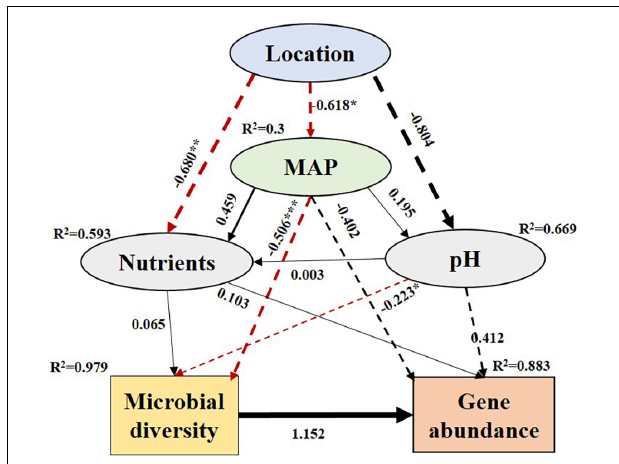
FIGURE 6 | Structural equation model (SEM) illustrating how environmental properties influenced the gene composition for N-metabolism by affecting the diversity of N- metabolism microorganisms. The solid and dashed arrows indicate the positive and negative nature of the path coefficients. The absolute value of the path coefficient corresponds to the line width. Paths that reach a significant level are shown with red lines. Adjacent values near the arrows indicate path coefficients. R 2 values indicate the proportion of variance explained by each variable. Significance levels are the same as above. *** p < 0.001, ** p < 0.01 and * p <